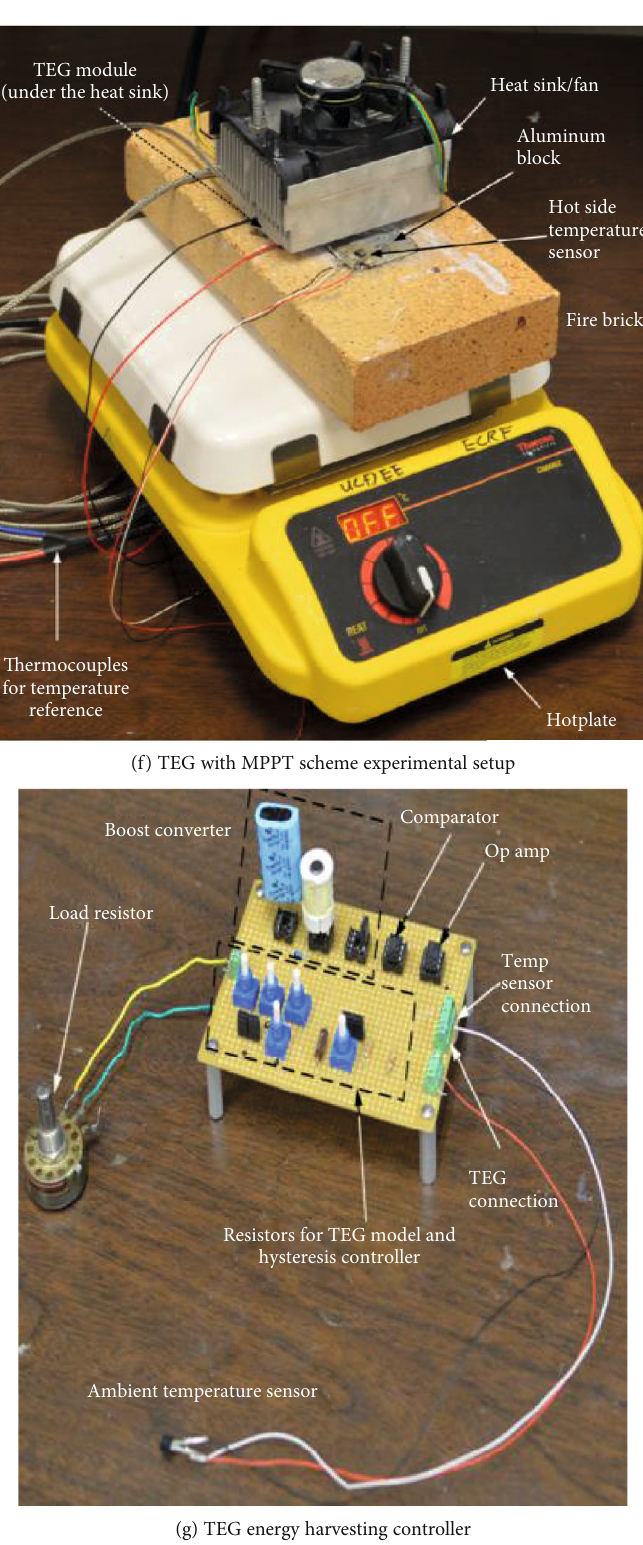
Figure 14: Uninterrupted TE energy harvesting with temperature sensor-based MPPT (adapted from